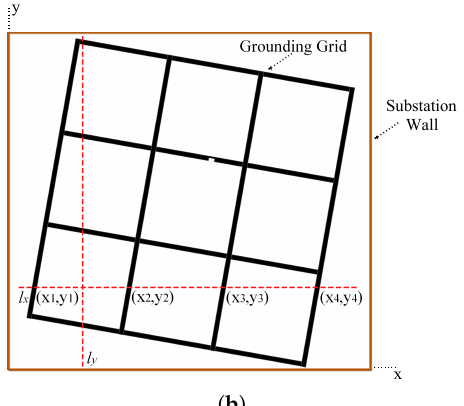
Figure 1. Depending on substation design requirements, grounding grid can be located at any angle with reference to substation boundary. ( a ) Orientation of grounding grid is assumed parallel to the substation boundary. For instance, the location of ground branches below l x are a function of x and similarly the location of ground branches below l y are a function of y . Therefore, line derivative technique can be used to determine grounding grid